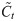
The repeating module in an LSTM.Here,xt and ht are the input vector and output result to the memory cell at time t, respectively. ht is the value of the memory cell. it, ft and ot are values of the input gate, the forget gate and the output gate at time t, respectively. Ct˜ are values of the the candidate state of the memory cell at time t.